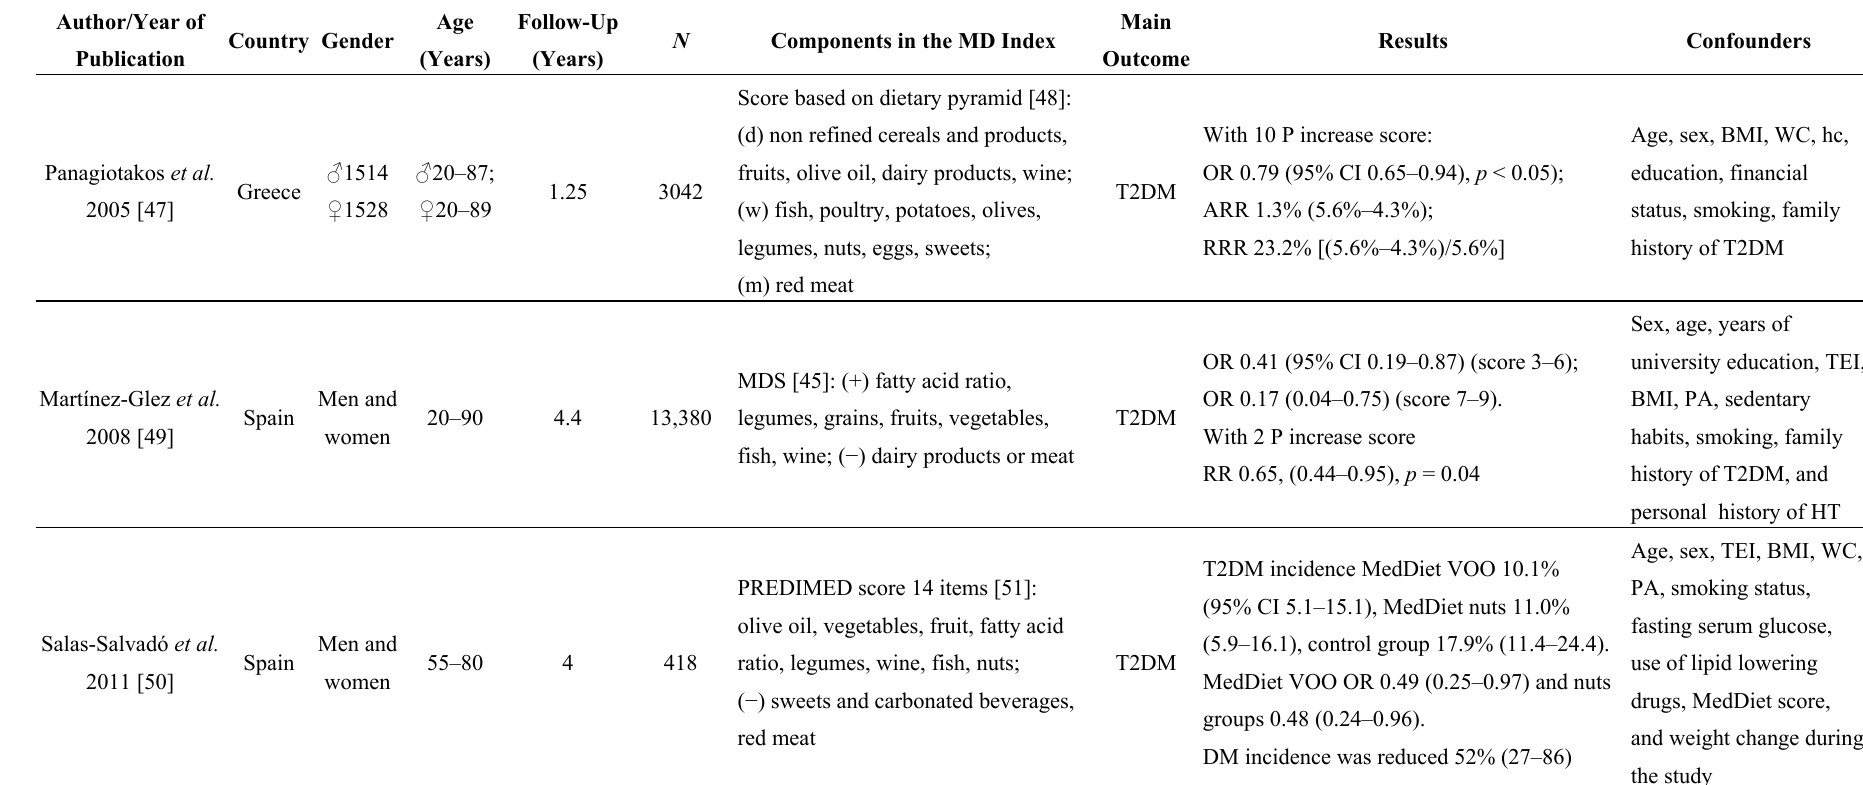
Table 1. Characteristics of the studies included evaluating the relationship between the Mediterranean Diet and